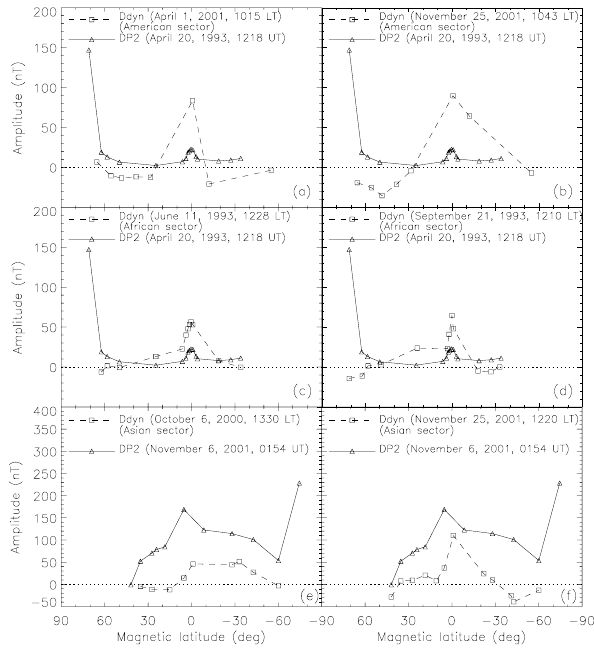
Fig. 11. Latitudinal profiles of the Ddyn disturbance compared with the latitudinal profile of the DP2 disturbance on 20 April 1993 at 12:18UT and 6 November 2001 at 01:54UT.